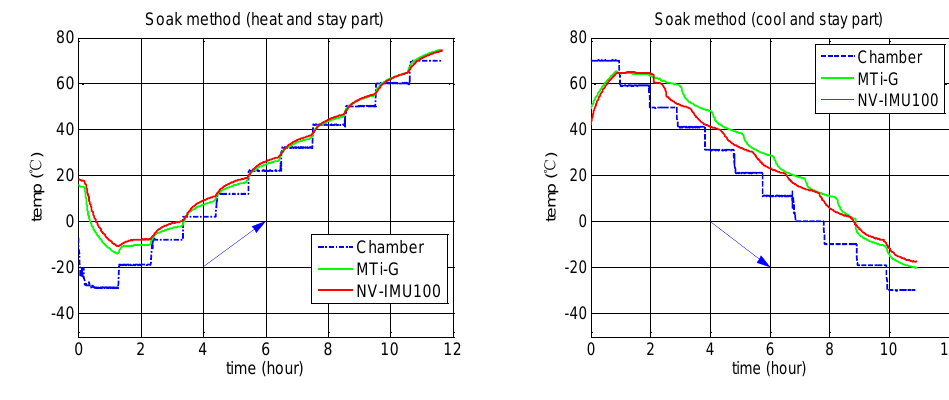
Figure 3. Temperature profile in Soak method test.